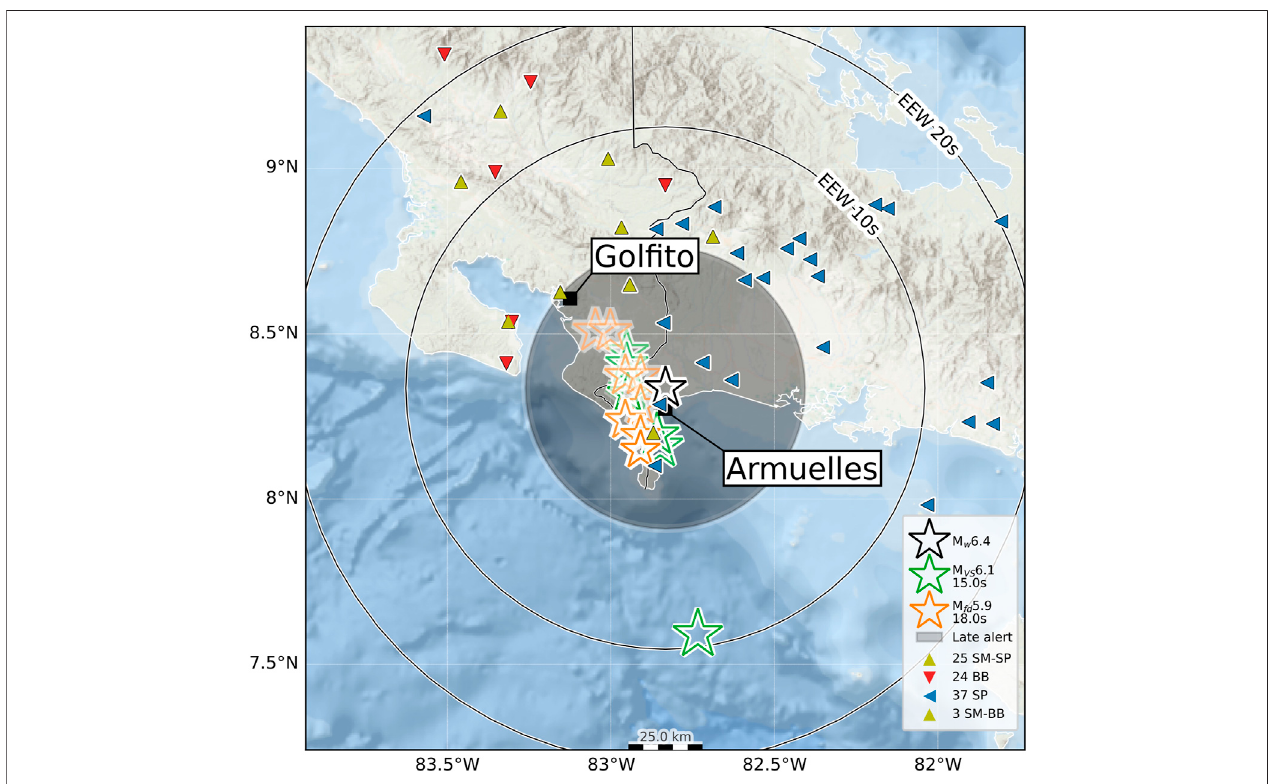
FIGURE 5 | Map of the 2019 Armuelles earthquake (Mw 6.4). Solutions provided by VS and FinDer are shown as green and orange stars, respectively. The RSN location is represented as a black star. Triangles represent the seismic stations and are color coded (see inset) based on the sensor type, as short period (SP), broad band(BB),andstrongmotion(SM).SPstationsareusedbyVS,butnotbyFinDer.TheblindzoneistheconcentricshadowareaaroundtheRSNlocationandrepresents the late alert zone. The thin black circles represent the warning time at different distances from the epicenter.